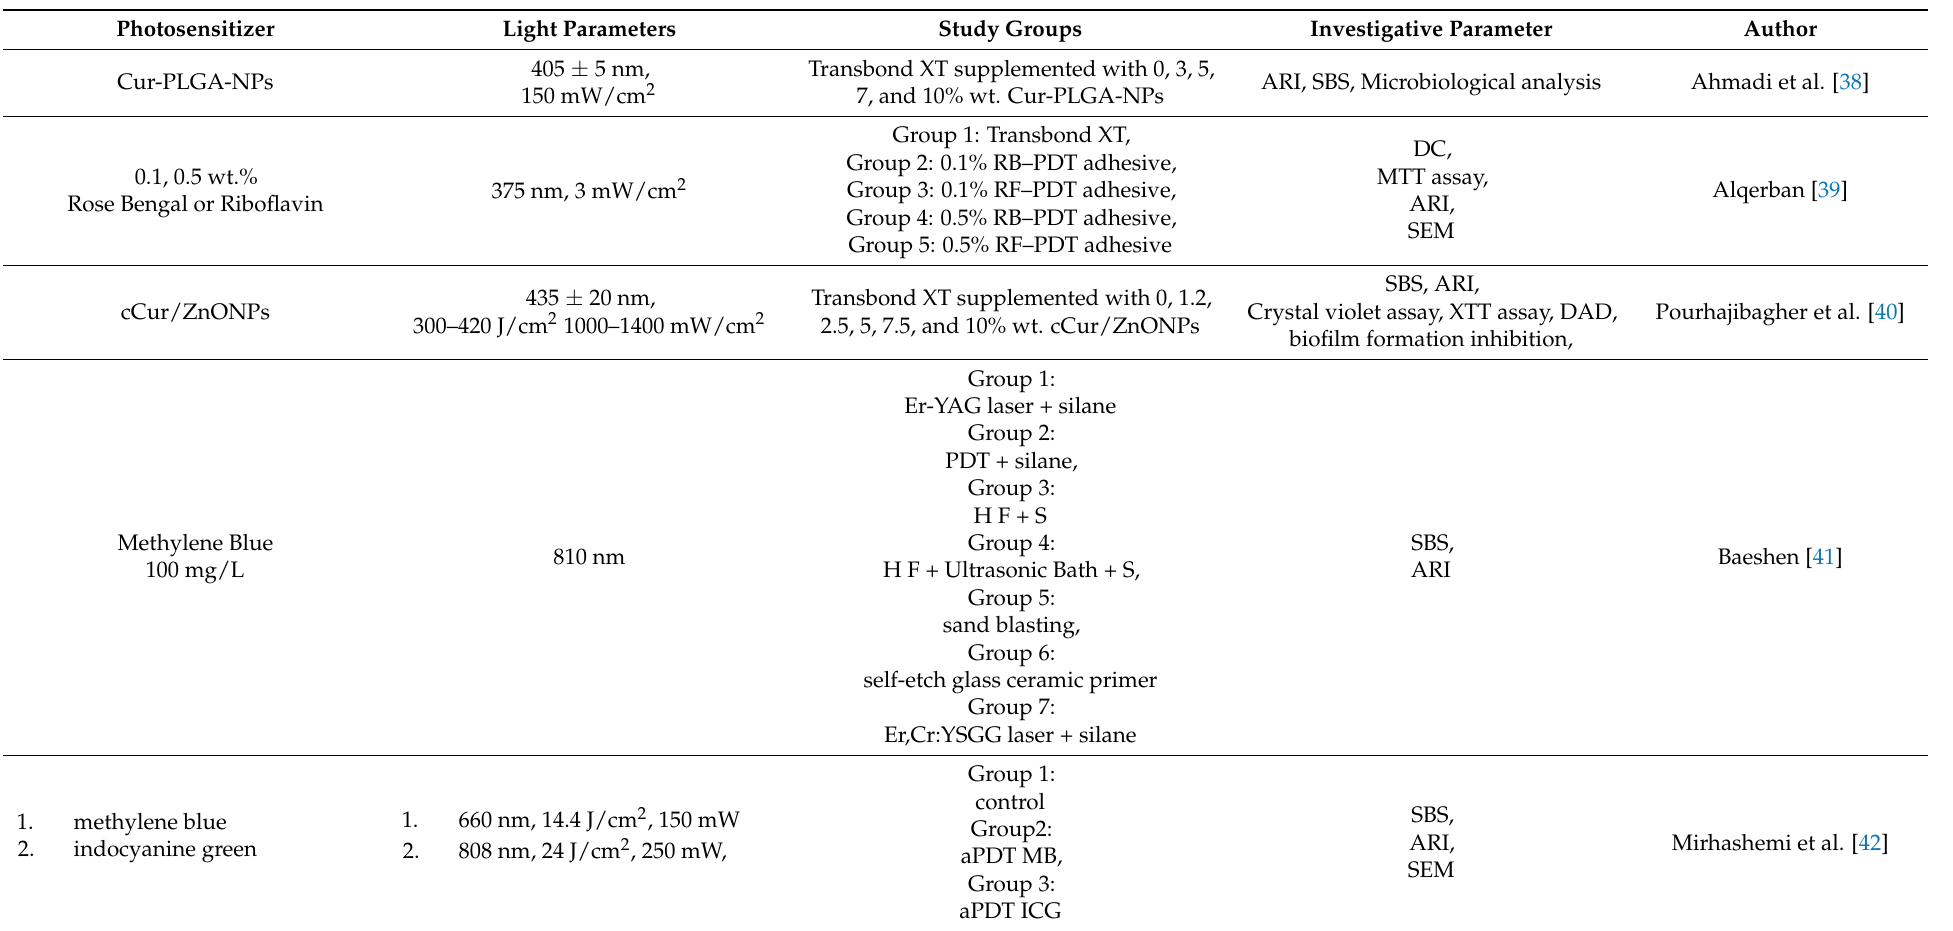
Table 2. Photodynamic therapy in ex vivo